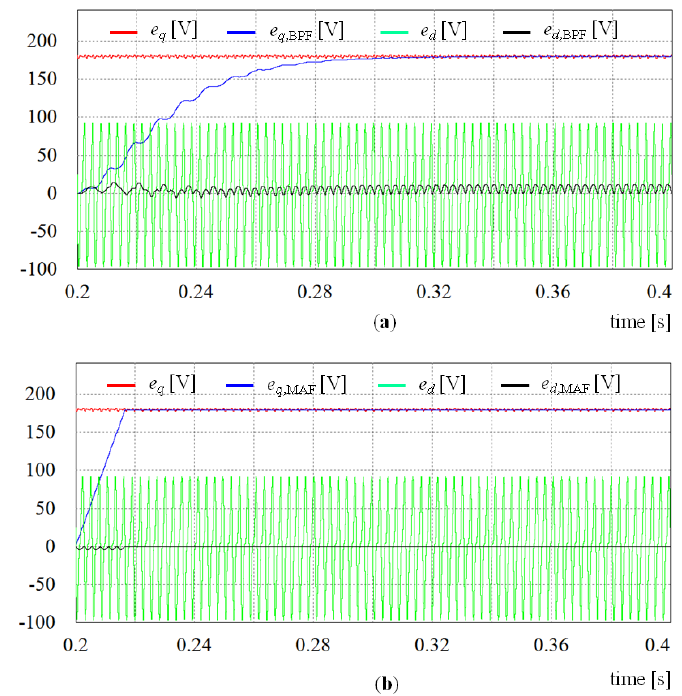
Figure 5. Performance comparison of dynamic responses between the band pass filter (BPF) and moving average filter (MAF) when direct current (DC)-quantity of grid voltages is extracted at the synchronous frame under the distorted grid voltages: ( a ) with BPF; and ( b ) with MAF.